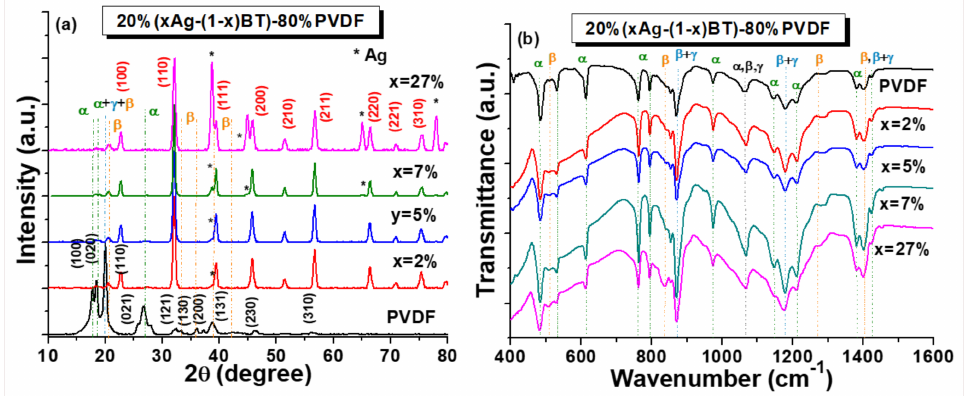
Figure 4. ( a ) XRD patterns and ( b ) FTIR spectra obtained for PVDF and 20%( x Ag − (1 − x )BT) − 80%PVDF composites with x = 2, 5, 7, and 27 vol.%